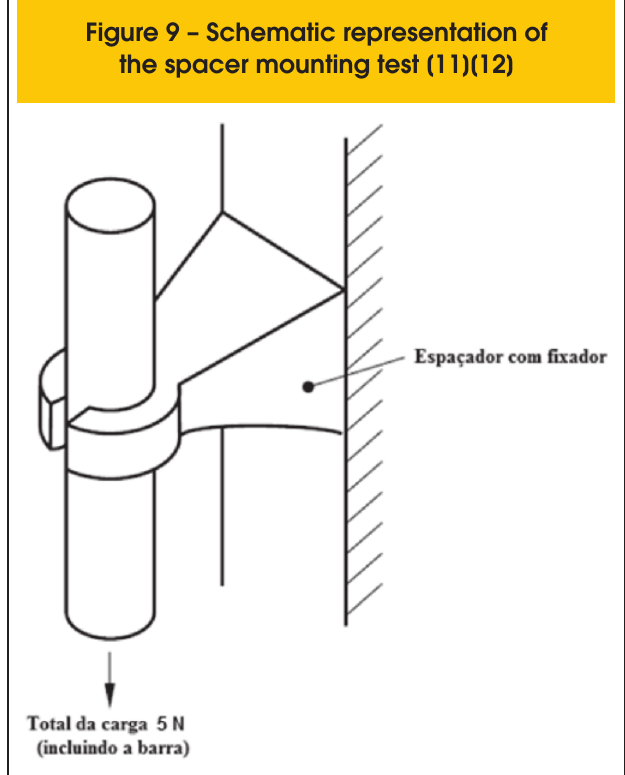
Figure 9 – Schematic representation of the spacer mounting test